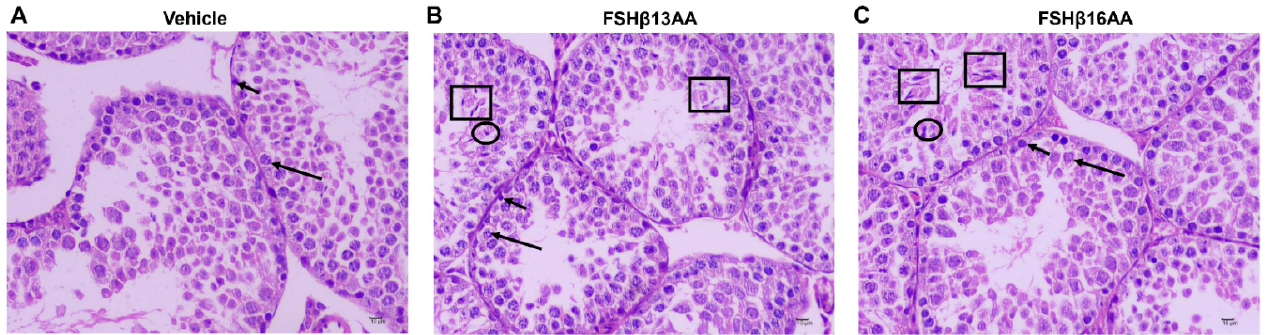
Figure 3. FSH β 13AA/FSH β 16AA on days 25 to 28 in the prepubertal male mice promote the complete spermatogenesis on day 29. ( A ) Representative photomicrographs of the testes from the control mice containing only spermatogonia (short arrow) and primary spermatocytes (long arrow). Photomicrographs of the testes from FSH β 13AA- ( B ) or FSH β 16AA-injected ( C ) males containing spermatogenic cells at various stages of development, including spermatogonia (short arrow), primary spermatocyte (long arrow), early spermatids (ellipse), late (mature) spermatids (square). Testes were stained with H&E ( × 400, scale bar = 10 µ m). The peptide treatments had no effects on the body, ovary or uteri weight on day 29 in female mice ( p > 0.05; Figure 4A–D), but increased the serum 17 β -estradiol concentrations ( p < 0.05, Figure 4E). Furthermore, FSH β 13AA upregulated ( p < 0.05; Figure 4F) the mRNA expressions of the steroidogenesis-associated genes HSD3 β 1 and Cyp19a1 , and the follicle development-associated genes Amh and Ar in the ovaries. With the exception of these genes, FSH β 16AA upregulated ( p < 0.05; Figure 4F) the mRNA expressions of the steroidogenesis-associated genes Star and Cyp17a1 , and the follicle development- associated genes Ccnd2 and Nobox in the ovaries and tended ( p < 0.1) to upregulate the mRNA expressions of Fshr , Foxo3a and Bmp15 . In addition, both FSH β 13AA and FSH β 16AA markedly promoted folliculogenesis (Figure 5A–C), as evidenced by more antral follicles (Figure